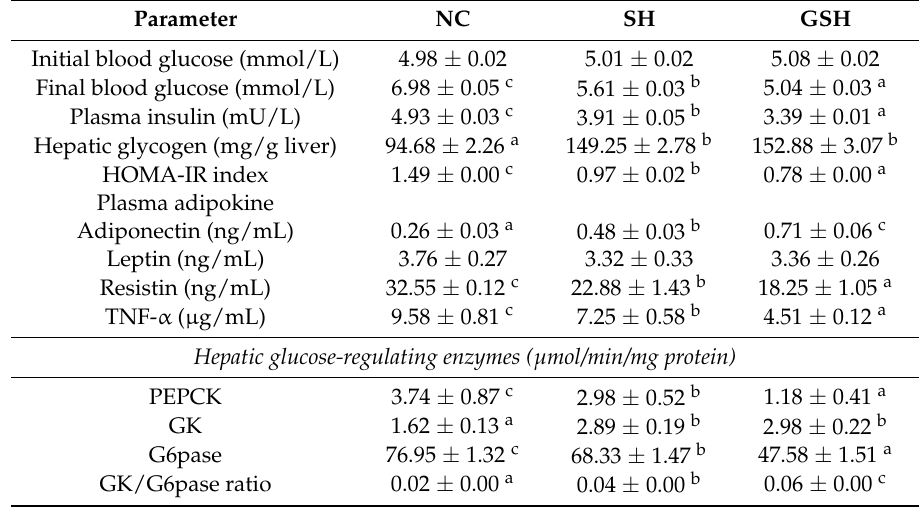
Table 4. Glucose profile, adipokine level, and glucose-regulating enzyme activity in ovariectomized rats fed with germinated Superhongmi rice